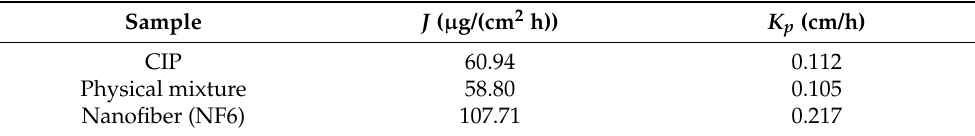
Table 7. Calculated flux ( J ) and permeability coefficient ( K p )